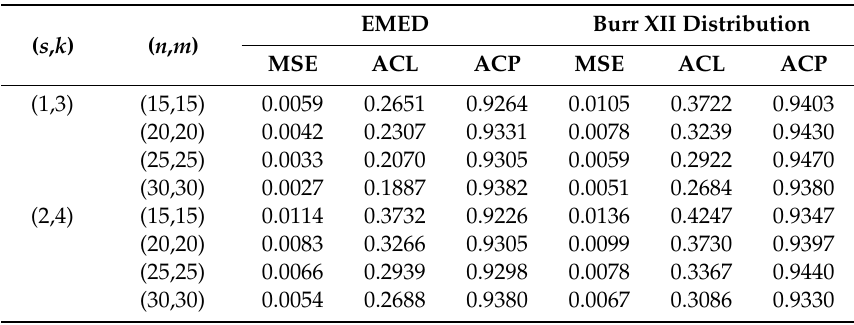
Table 6. Comparison of MSE, the average confidence length (ACL), and 95% average coverage probability (ACP) at ( α 1 , α 2 ) = (1.5, 1.5) for two distributions. EMED, exponentiated moment-based exponential